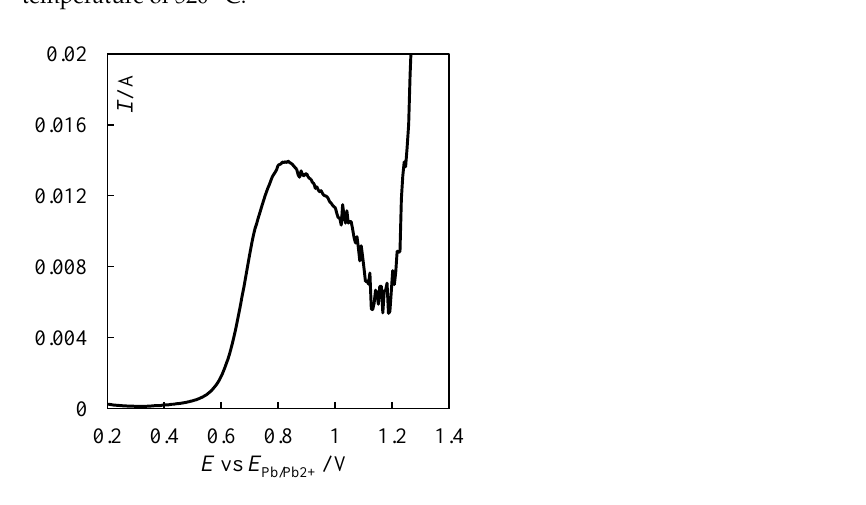
Figure 4. CV in the PbCl 2 melt containing 0.5 wt% of PbO at a potential sweep rate of 0.1 V s −1 and a temperature of 520 °C.